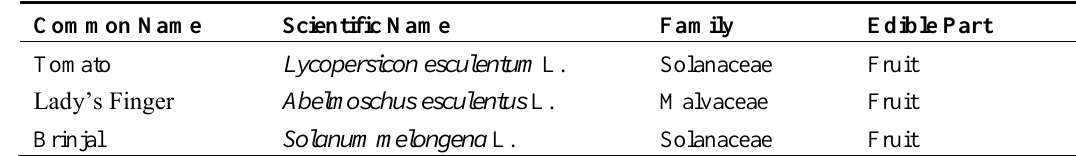
Table 1. Vegetable samples used for the present